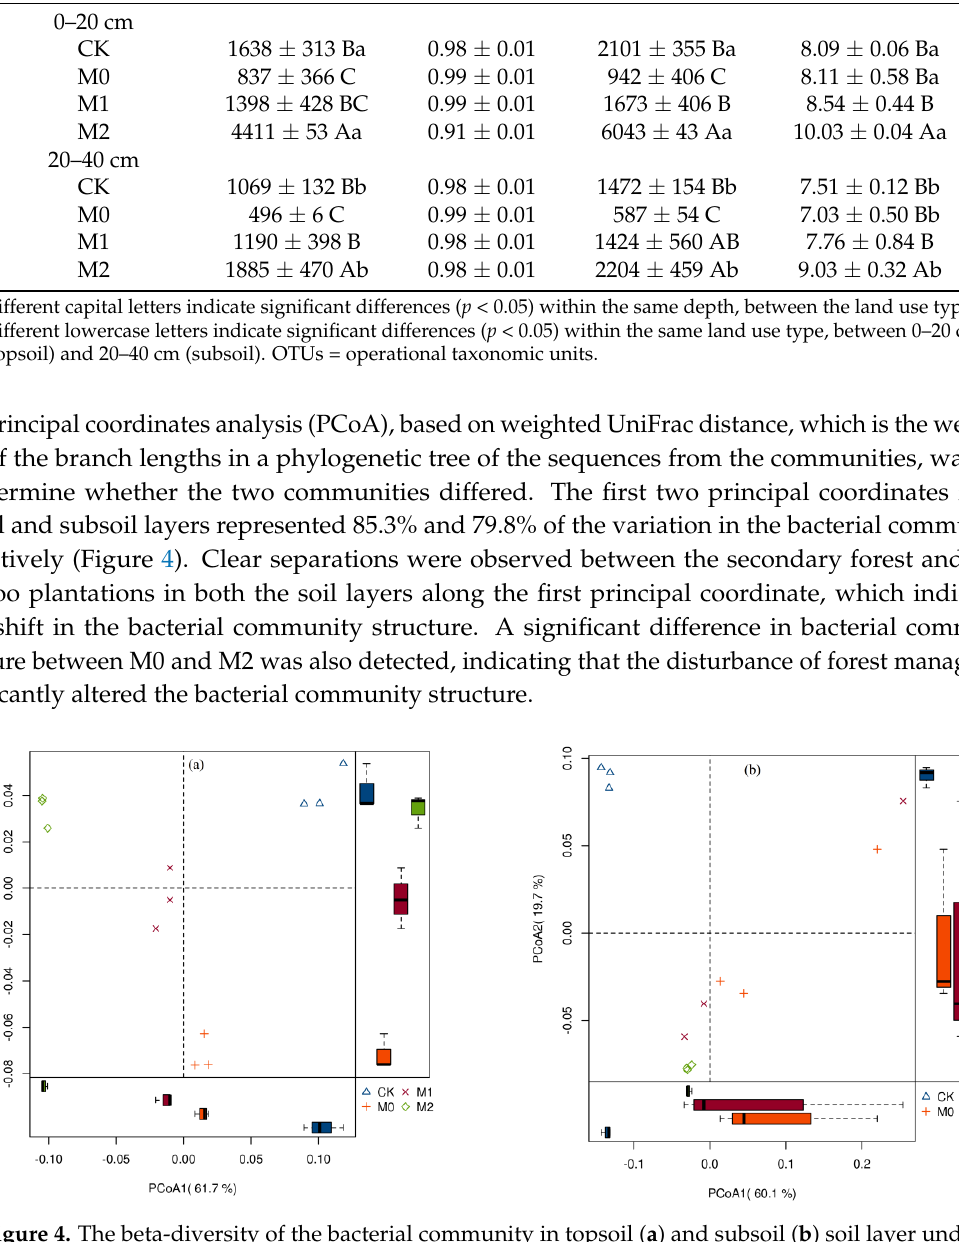
Table 5. Pearson’s correlation for testing the association among bacterial diversity indices, soil hydrophobicity, and C mineralization rate.